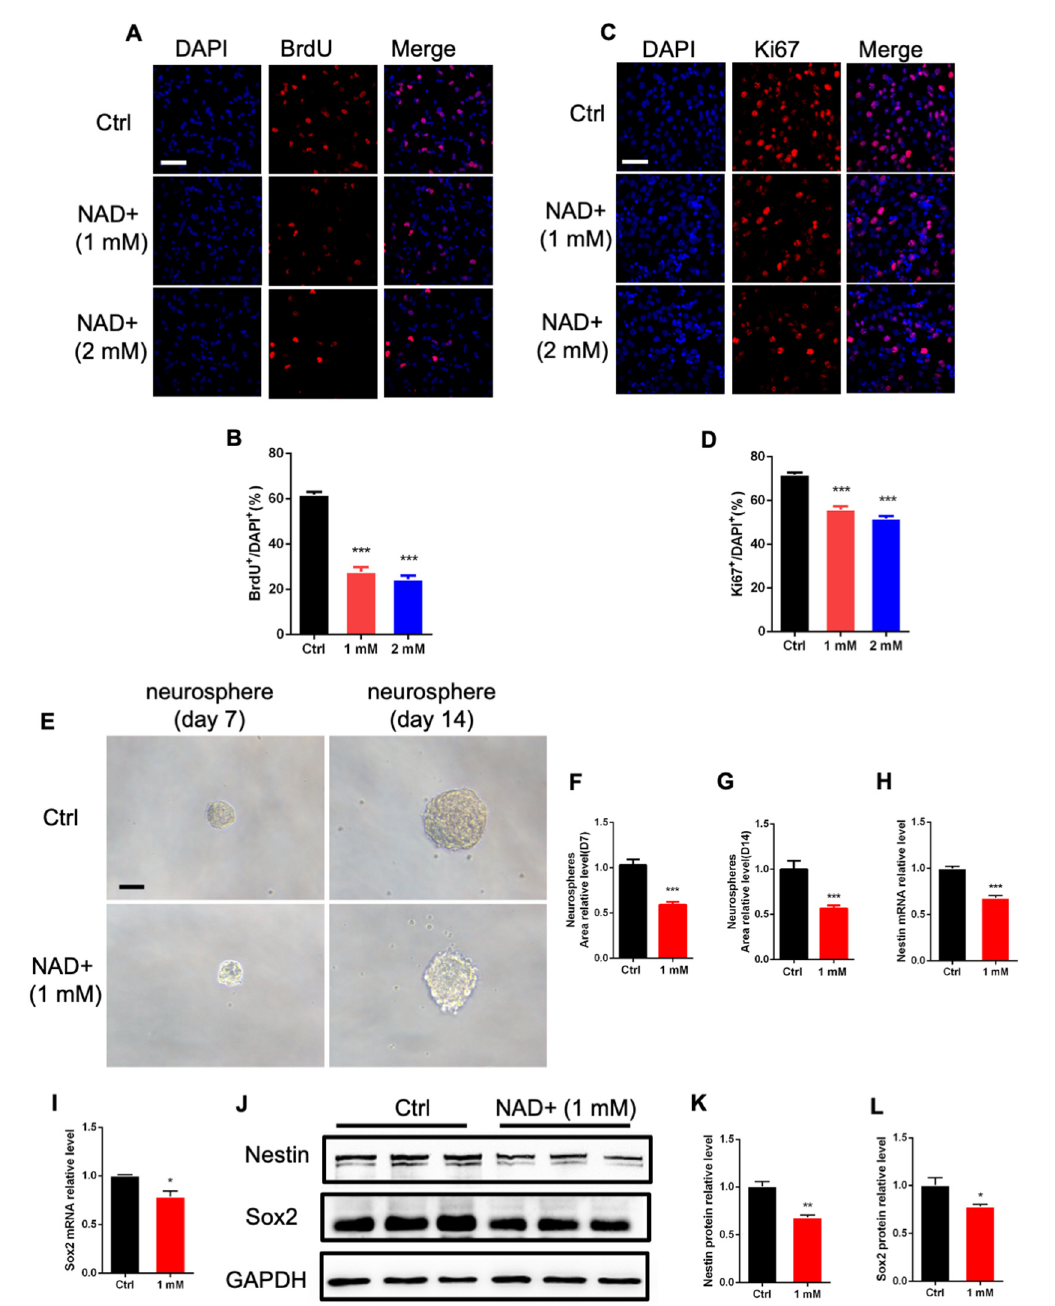
Figure 1. NAD+ exposure affects the proliferation of adult neural stem/progenitor cells in vitro . ( A ) Representative images of BrdU immunostaining with control (Ctrl) and NAD+-treated adult neural stem/progenitor cells (aNSPCs). Scale bar, 50 μ m. ( B ) Quantification results show that NAD+ exposure decreased the percentages of BrdU + cells under proliferation conditions. Data are presented as the mean ± SEM. n = 3 independent experiments, unpaired t -test. ( C ) Representative images of Ki67 immunostaining with Ctrl and NAD+-treated aNSPCs. Scale bar, 50 μ m. ( D ) Quantification results show that NAD+ exposure decreased the percentages of Ki67 + cells. Data are presented as the mean ± SEM. n = 3 independent experiments, unpaired t -test. ( E ) Representative images of neurospheres derived from single aNSPCs. aNSPCs were supplemented with 1 mM NAD+ and analyzed at days 7 and 14. Scale bar: 50 μ m. ( F , G ) Quantification results show that NAD+ exposure decreased the size of neurospheres at day 7 ( F ) and day 14 ( G ). Data are presented as the mean ± SEM. n = 30 neurospheres for Ctrl and NAD+ exposure groups at each timepoint. unpaired t -test. ( H , I ) The rel- ative mRNA levels of Nestin and Sox2 of Ctrl and NAD+ supplemented aNSPCs. Data are presented as the mean ± SEM. n = 3 independent experiments, unpaired t -test. ( J – L ) Western blot assay ( J ) and